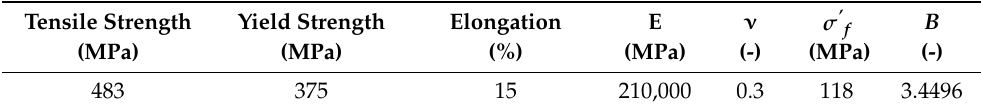
Table 1. Mechanical properties and material constants of the material. Tensile Strength